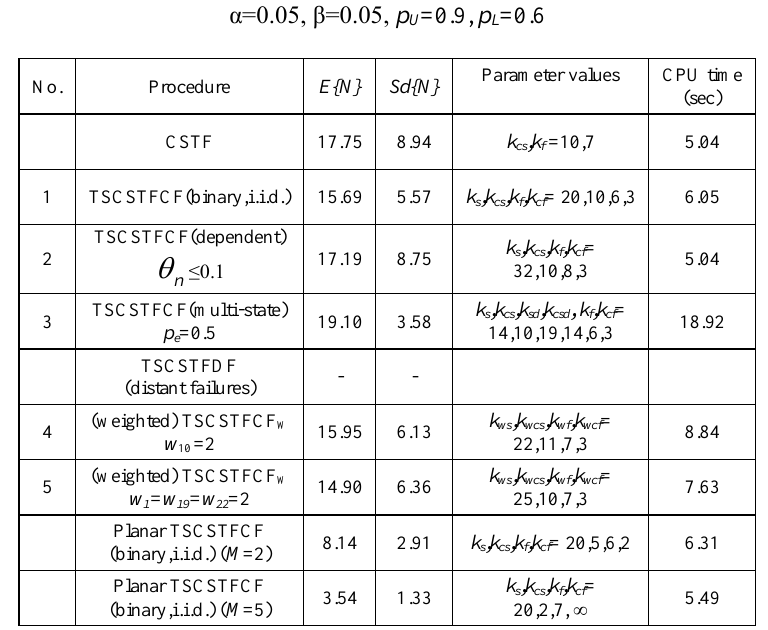
Table 4. Optimal values of the expected number of tests for different